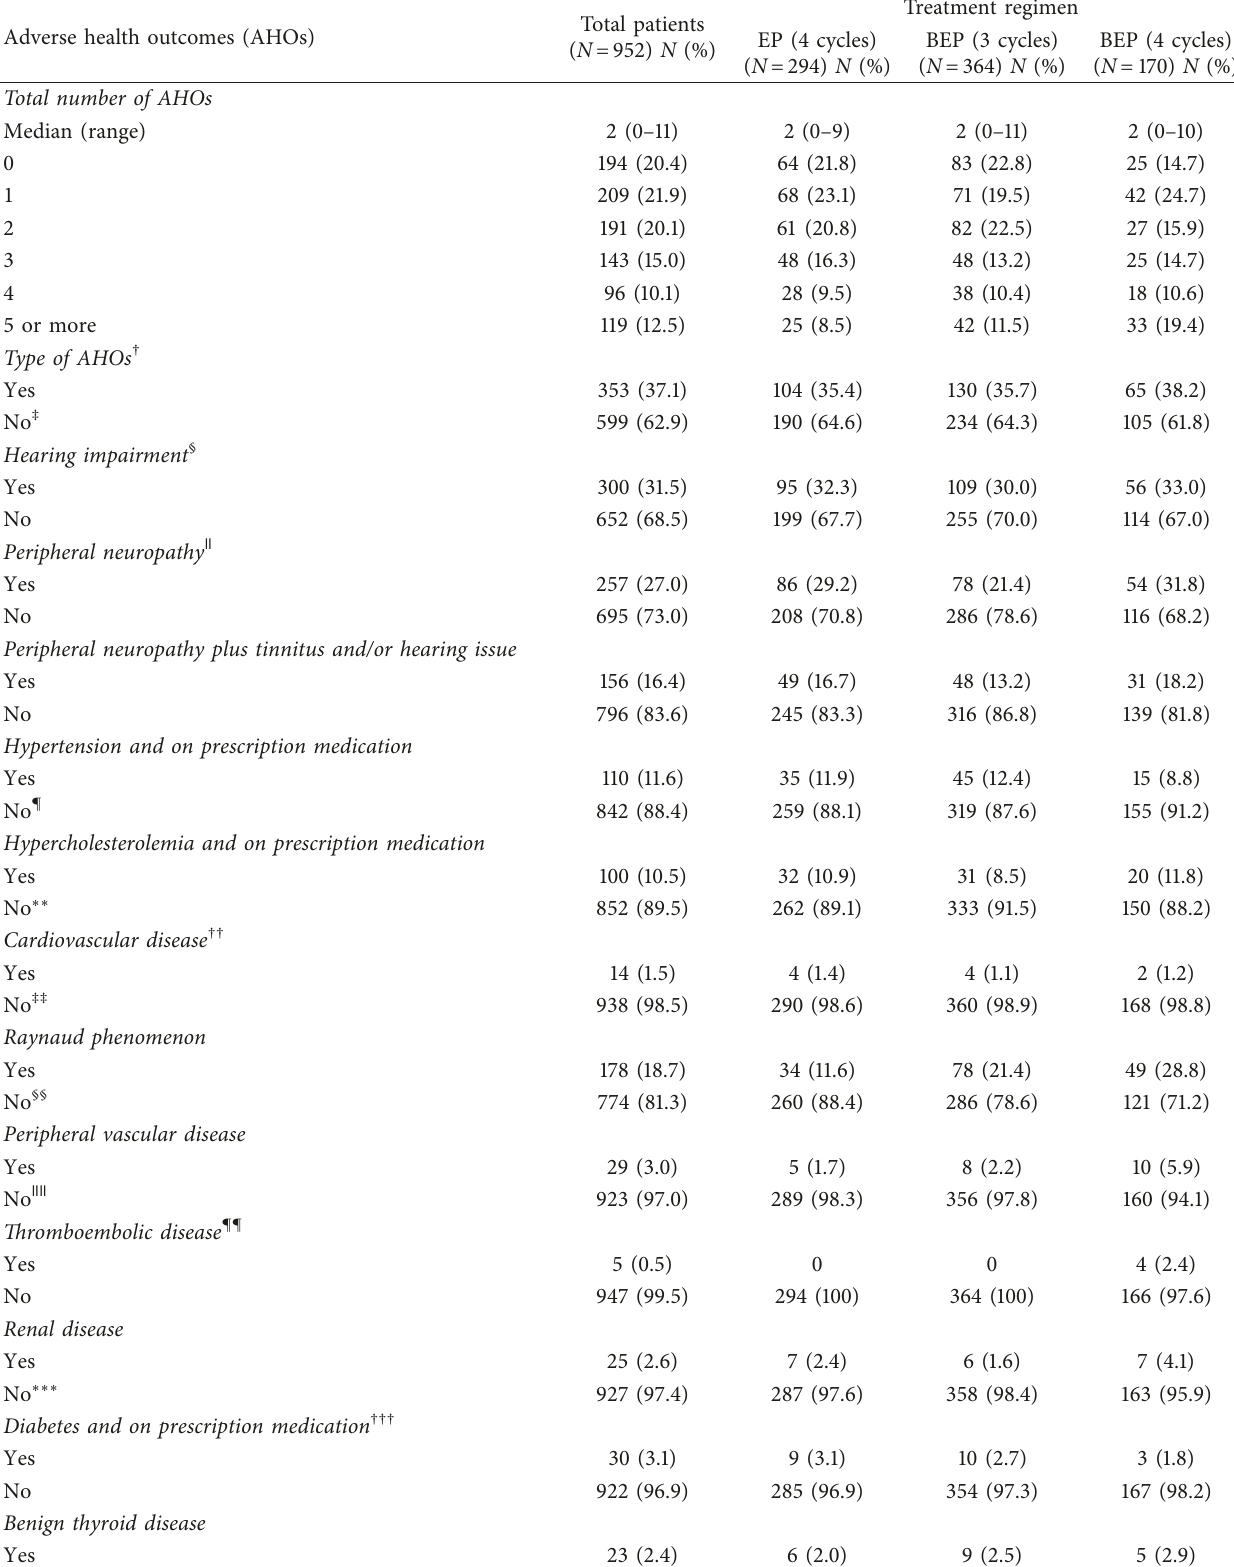
Table 3: Numbers and types of self-reported adverse health outcomes among 952 cisplatin-treated germ cell tumor survivors in North America ∗